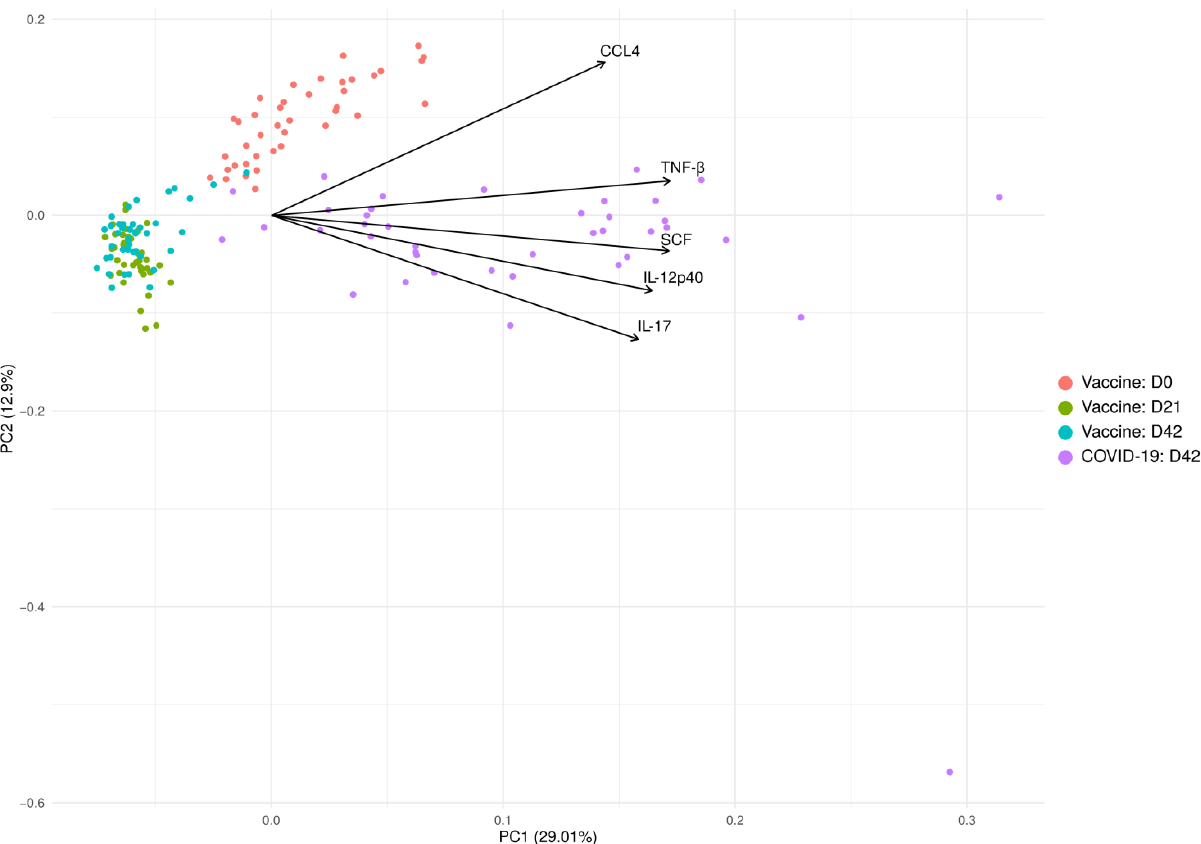
Figure 7. PCA is based on the levels of cytokines in SputnikV vaccinated and convalescent COVID-19 sera. The top 5 variables (arrows) with the highest contribution are presented. PCA reduces the dimension of multidimensional data (48 cytokines) to two (2 axis — PC1 and PC2), which could be visualized with minimal loss information.